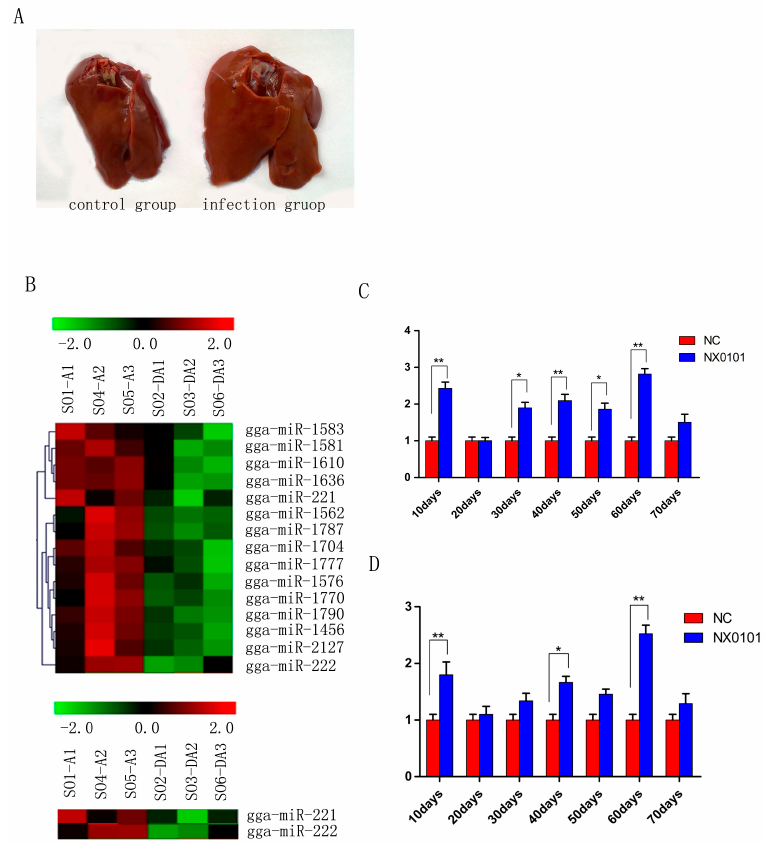
Figure 1. gga-miR-221 and gga-miR-222 expression was upregulated in ALV-J induced cancer. ( A ) Liver lesions in SPF white leghorn chickens induced by viral infection at 70 days; ( B ) Microarray analysis of miRNA expression during ALV-J infection. DA represents the control group and A represents tte infection group; ( C ) and ( D ) gga-miR-221 and gga-miR-222 expression levels in the liver of ALV-J infected chickens were quantified by qRT-PCR every 10 days from 10 to 70 days (** p < 0.01; * p < 0.05).